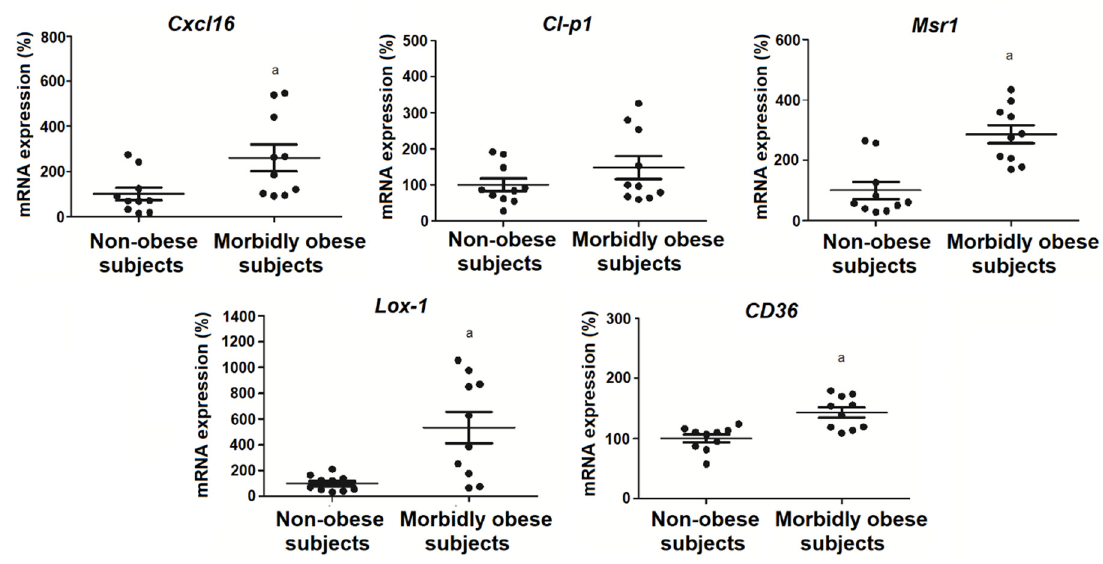
Figure 6. Levels of mRNA expression of scavenger receptors in visceral mature adipocytes obtained from visceral adipose tissue of non-obese ( n = 10) and morbidly obese subjects ( n = 10). a p < 0.05: significant differences with regard to non-obese subjects.